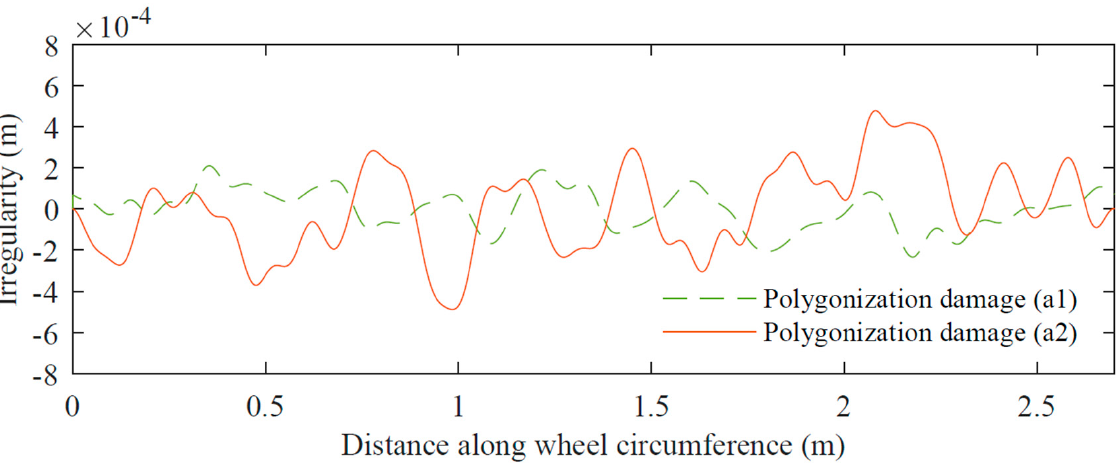
Figure 8. Examples of polygonization-damaged profiles based on Figure 6b irregularity spectrum with different wear ranges: a1 (0.2–0.6) mm and a2 (0.8–1.2) mm.